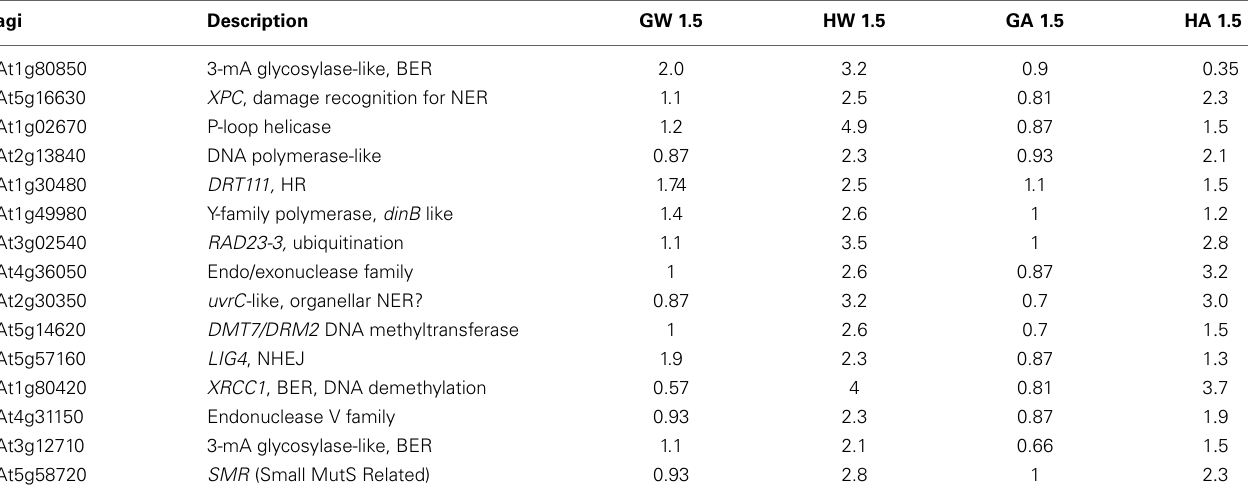
Table 2 | “DNA metabolic response” transcripts induced by HZE, but not Gamma irradiation at 1.5h after IR. agi